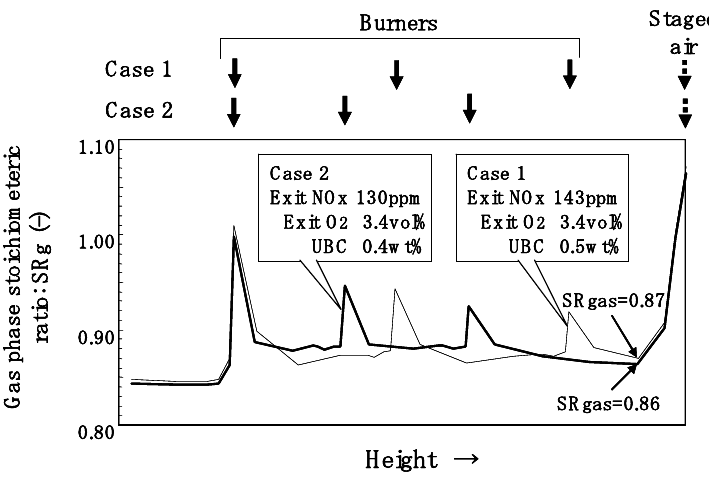
Figure 14. Distribution of calculated gas phase stoichiometric